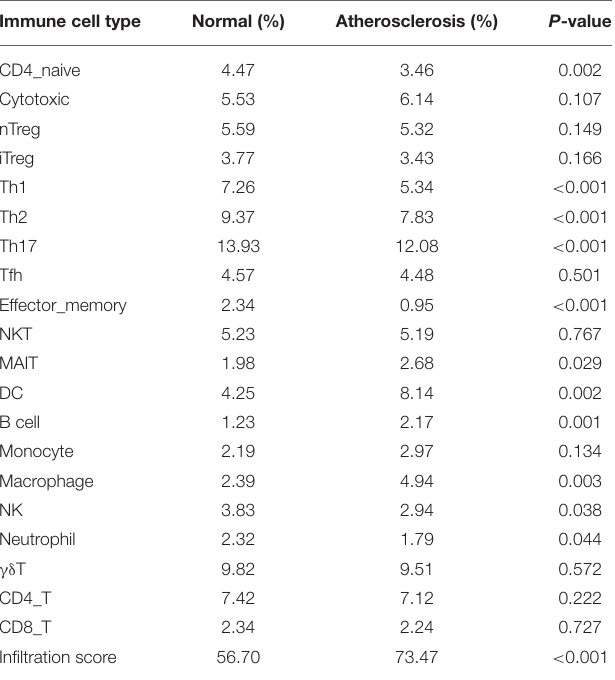
TABLE 1 | Immune cell abundance identifier (ImmuCellAI) fraction of infiltration of immune cells in atherosclerotic and normal carotid tissues. Immune cell type